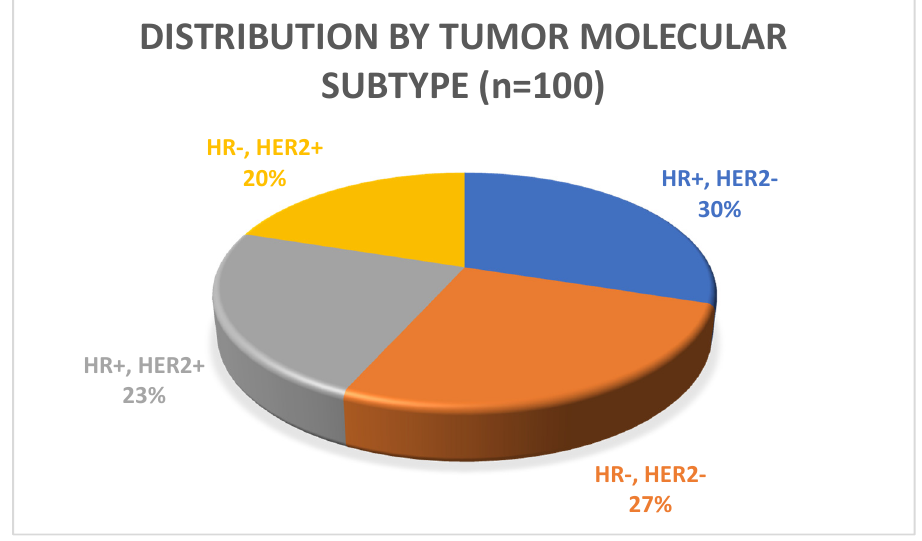
Figure 3. Patient distribution by tumor molecular subtype (by immunohistochemistry (IHC) (n = 100), (HR = hormone receptor, HER2 = human epidermal growth factor) .